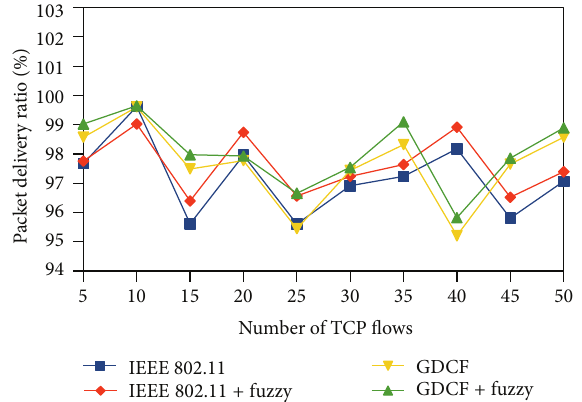
Figure 14: Packet delivery ratio for 1000 ∗ 1000 scenario.